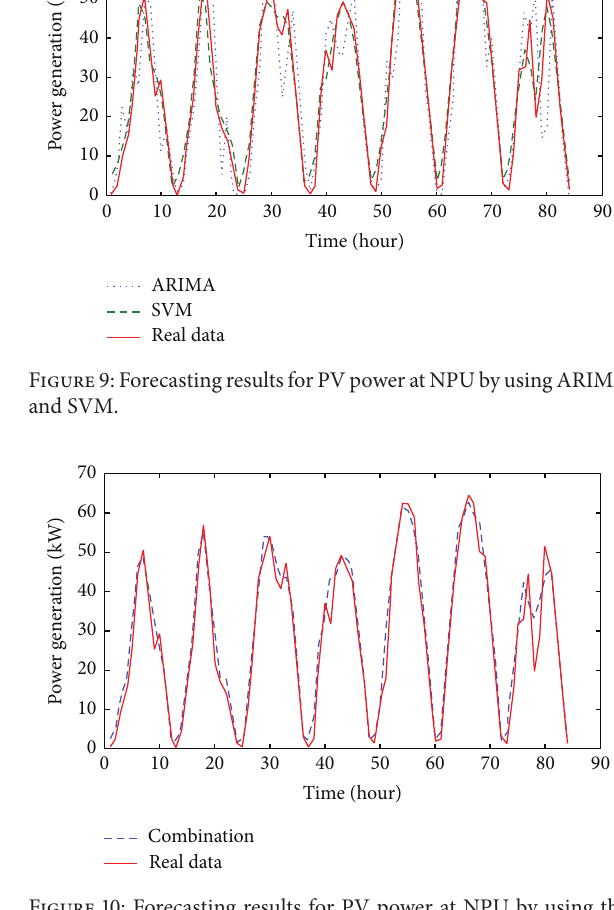
Figure 10: Forecasting results for PV power at NPU by using the hybrid combination